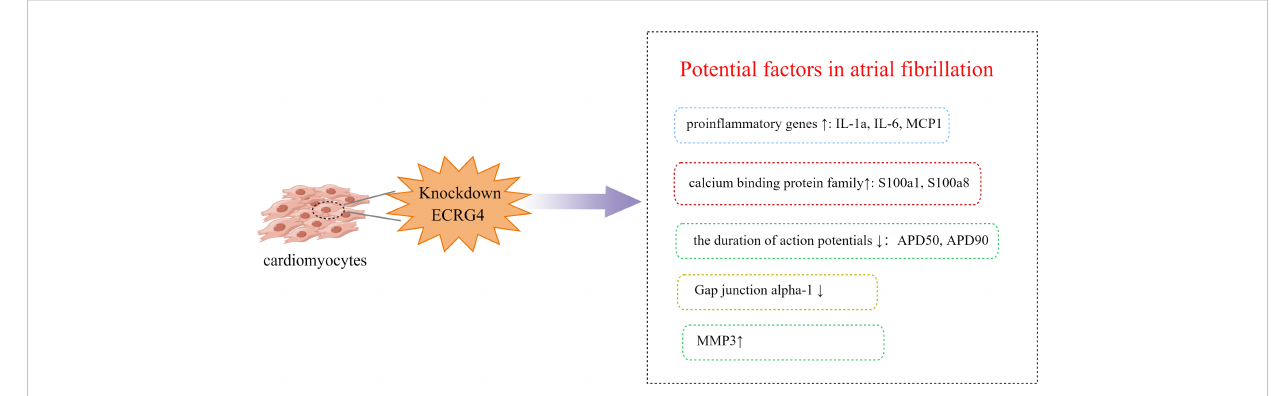
FIGURE 2 Mechanism of atrial fi brillation induced by down-regulation